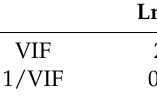
Table 9. The VIF test.